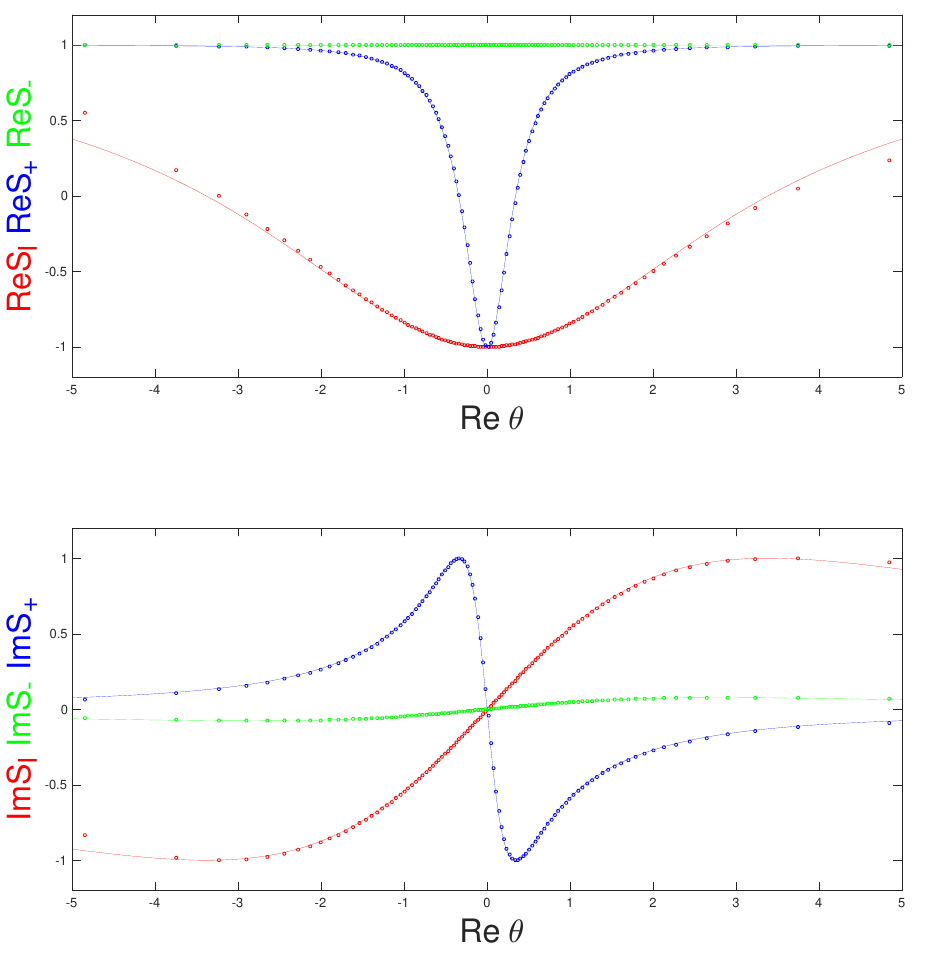
Figure 5. The comparison of the maximization results with the exact integrable model for N = 20. We use 200 points for interpolation and choose an initial functional F = Re[ S 1 ( (cid:18) 0 ) (cid:0) (cid:11)S 2 ( (cid:18) 0 )] with (cid:18) 0 ’ i ( z 0 = 0 : 3 i ) and (cid:11) = 3. Here we plot the real and imaginary parts of S I , S + and S (cid:0) on the physical line where the dots indicate maximization results while the curves are the exact integrable